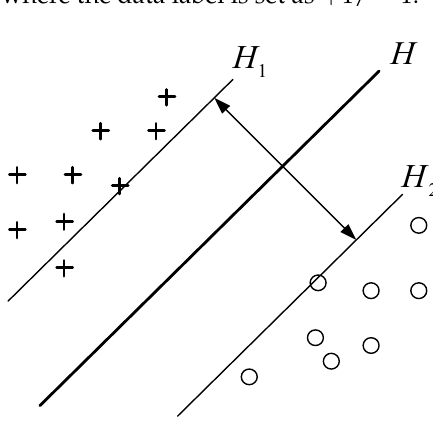
Figure 4. Optimal segmentation hyperplane.